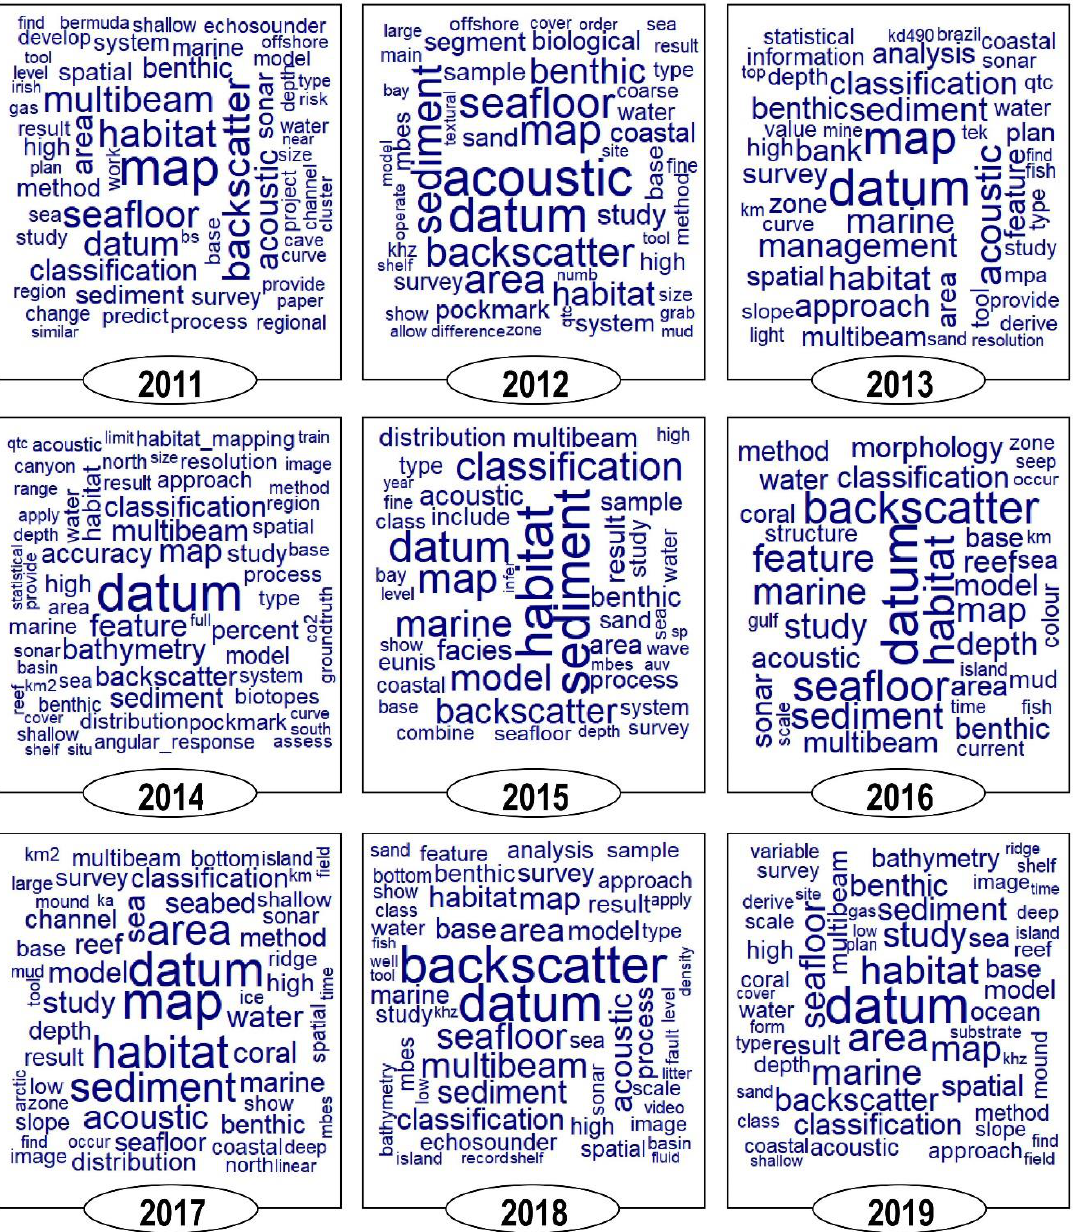
Figure 8. Word cloud composition for each year over the last decade.